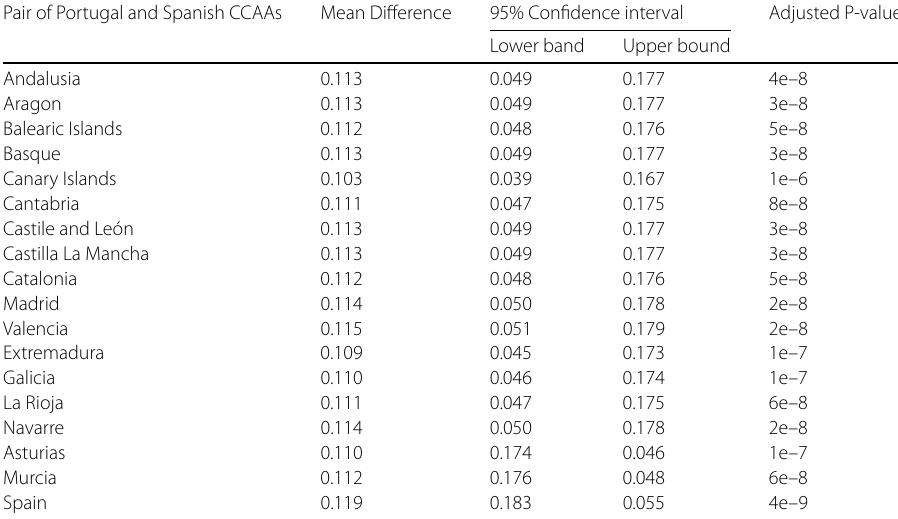
Table 16 HSD Tukey test results filtered by for the pair of CCAAs-countires which include Portugal Pair of Portugal and Spanish CCAAs Mean Difference 95% Confidence interval Adjusted P-value Lower band Upper bound Andalusia